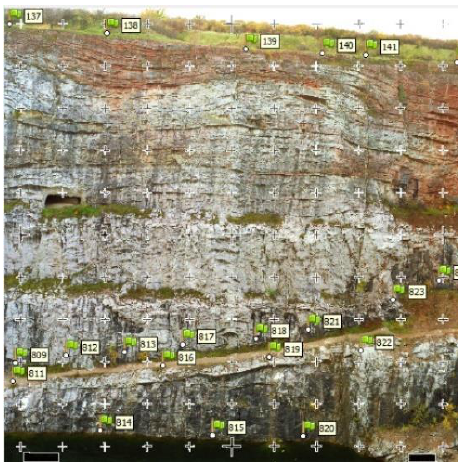
Figure 6. Distribution of GCPs and control points on image.